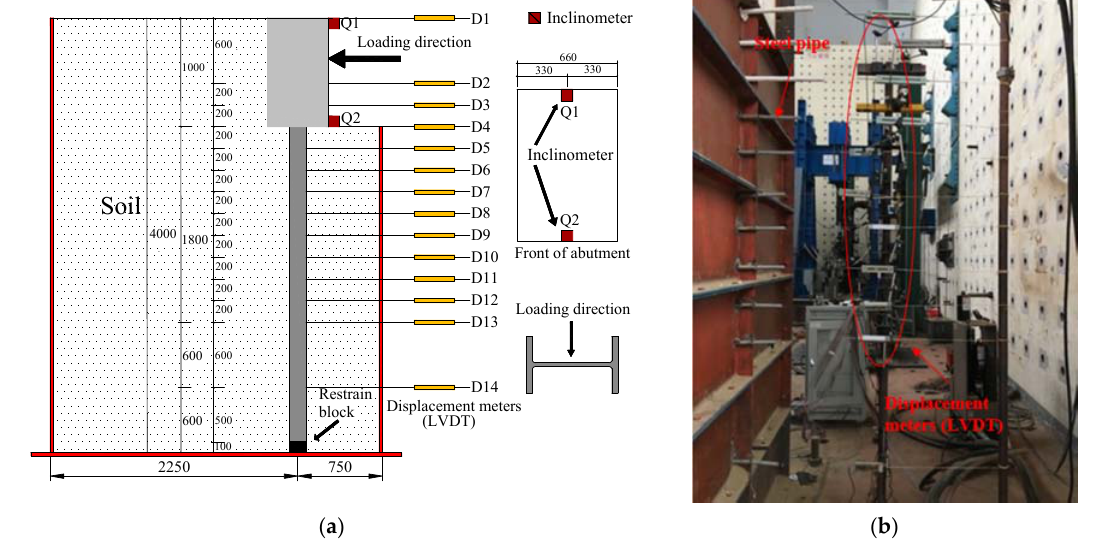
Figure 6. Layout of displacement meters and inclinometers (unit: mm). ( a ) Layout. ( b ) Photo of displacement meters.